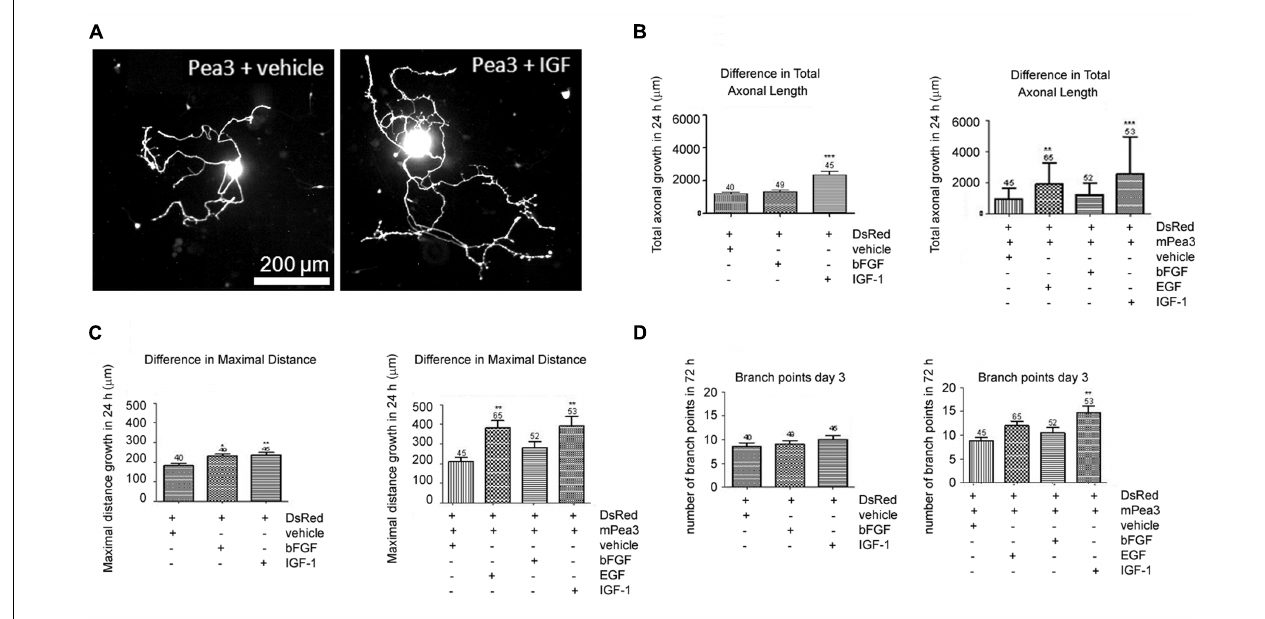
FIGURE 2 |Adult DRG neurons co-transfected with Pea3 expression vector and DsRed and stimulated with bFGF, EGF, or IGF-1. (A) representative images of DRG neurons co-transfected with Pea3 and DsRed, stimulated with IGF-1; (B) total axonal growth in adult DRG neurons transfected with DsRed alone (left panel; IGF-1 and bFGF compared with control, using one way ANOVA test withTukey’s post test, ** p < 0.01, *** p < 0.001), or co-transfected with DsRed and mPea3, in the presence or absence of growth factors (right panel; EGF, IGF-1, and bFGF compared with control, using one-way ANOVA test withTukey’s post test, ** p < 0.01, *** p < 0.001); (C) difference in maximal axonal outgrowth normalized to control cells transfected with DsRed alone (left panel; IGF-1 and